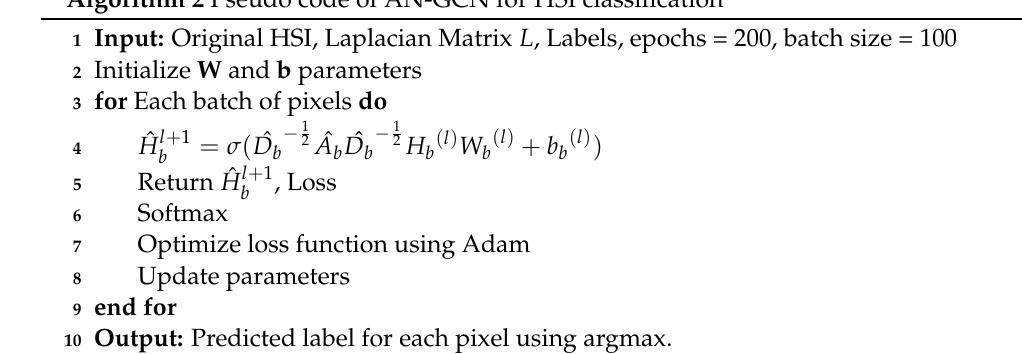
Algorithm 2 Pseudo code of AN-GCN for HSI classification